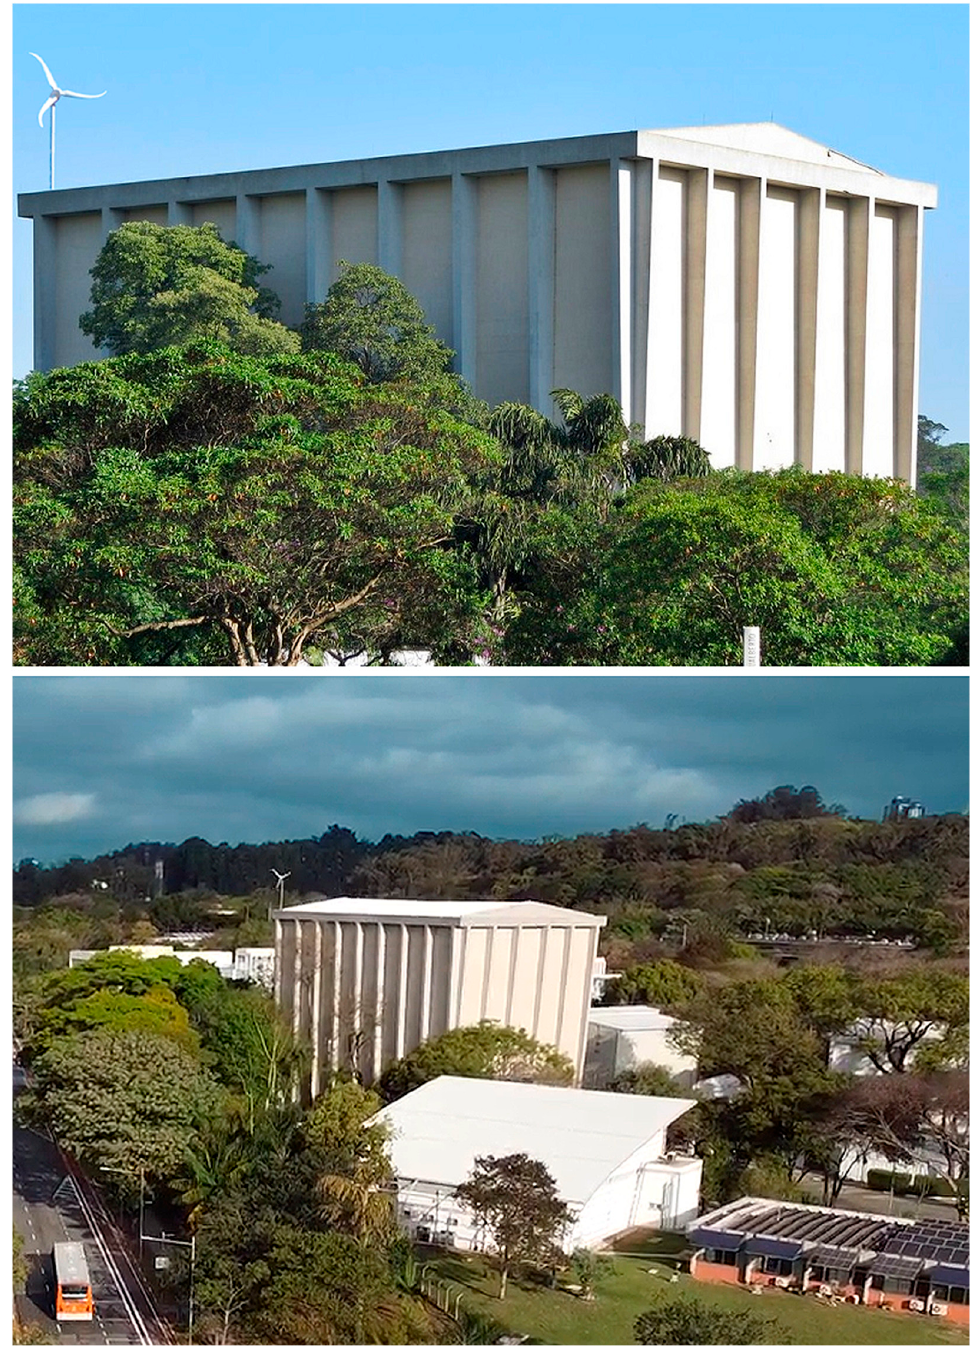
Figure 5. Views of the SWT implantation at the High Voltage Laboratory building of the University of São Paulo campus (São Paulo, Brazil).